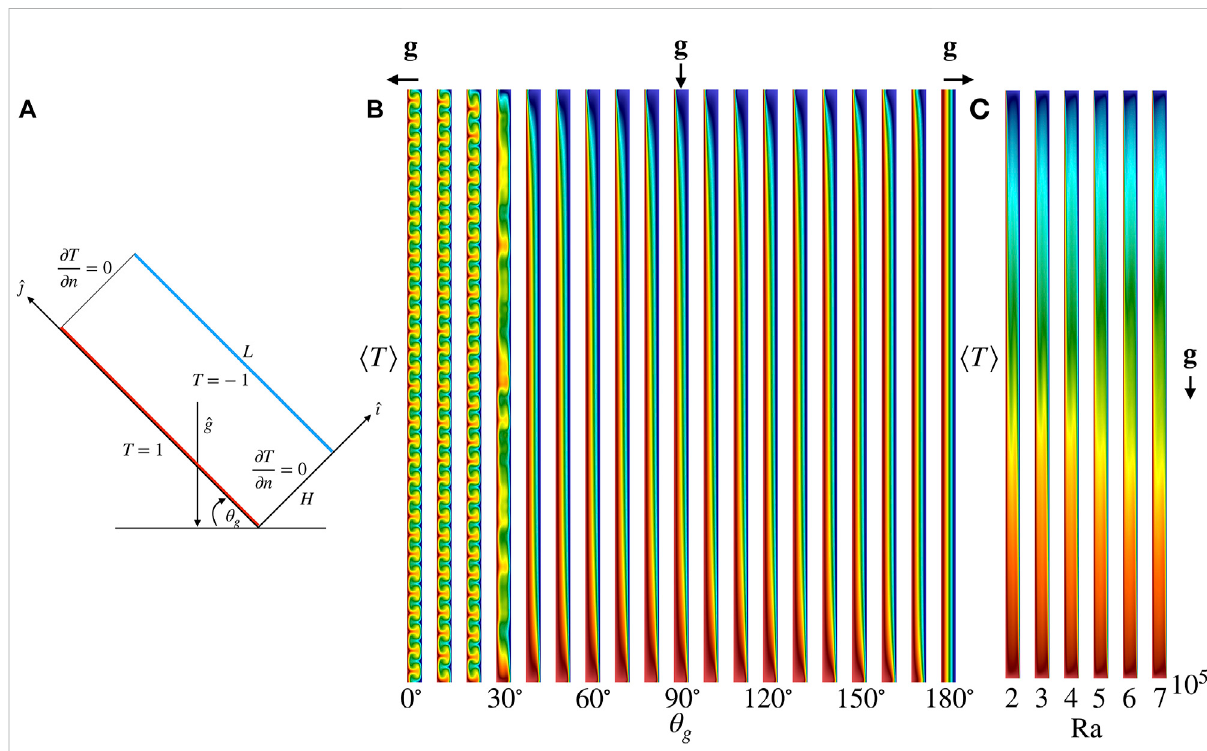
FIGURE 1 (A) Problemcon fi guration. (B) FOMmean(orsteady)temperaturefor19 uniformly-spaced θ g ∈ [0 ° ,180 ° ]atRa=10 4 andPr =7.2. (C) FOMmean temperature for 6 uniformly-spaced Ra ∈ [2 × 10 5 , 7 × 10 5 ] at θ g = 90 ° and Pr =